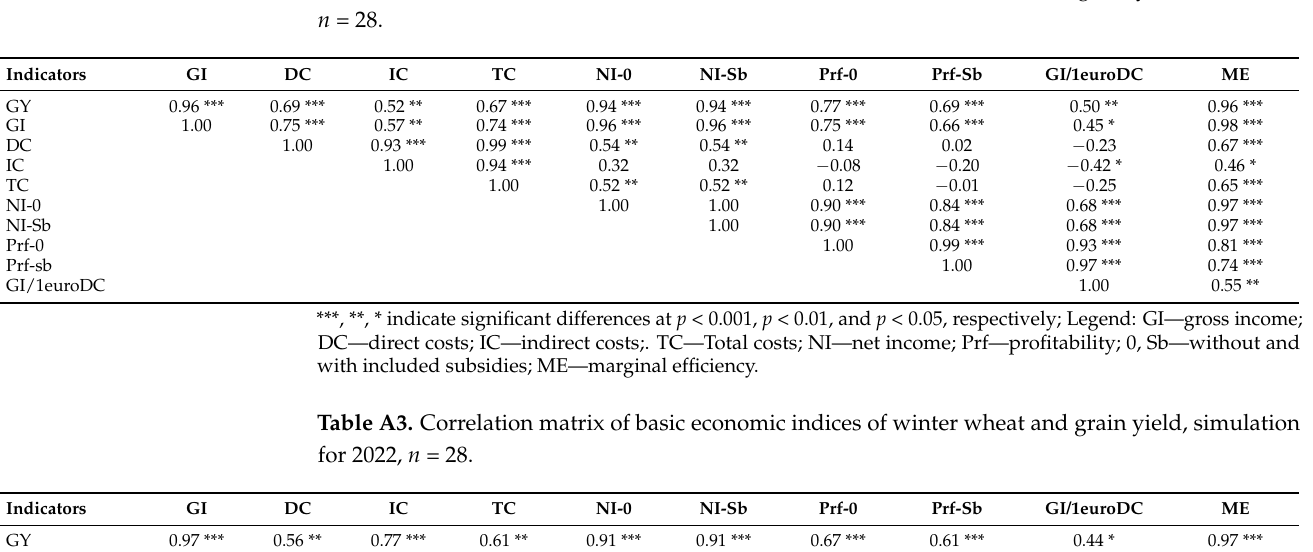
with fungicides.—simulation 2022; Figure S11: Regression models of net profitability response to increasing rates of fertilizer nitrogen on the backgroung of winter wheat protection with fungicides.— simulation 2022; Figure S12: Regression models of marginal efficiency response to increasing rates of fertilizer nitrogen on the backgroung of winter wheat protection with fungicides;—simulation 2022; Figure S13: Effect of winter wheat protection with fungicides and rates of fertilizer nitrogen on unit productivity of direct costs. Similar letters in the column means a lack of significant differences using Tukeys’ test; The vertical bar in the column refers to the standard error of the mean;—simulation 2022.